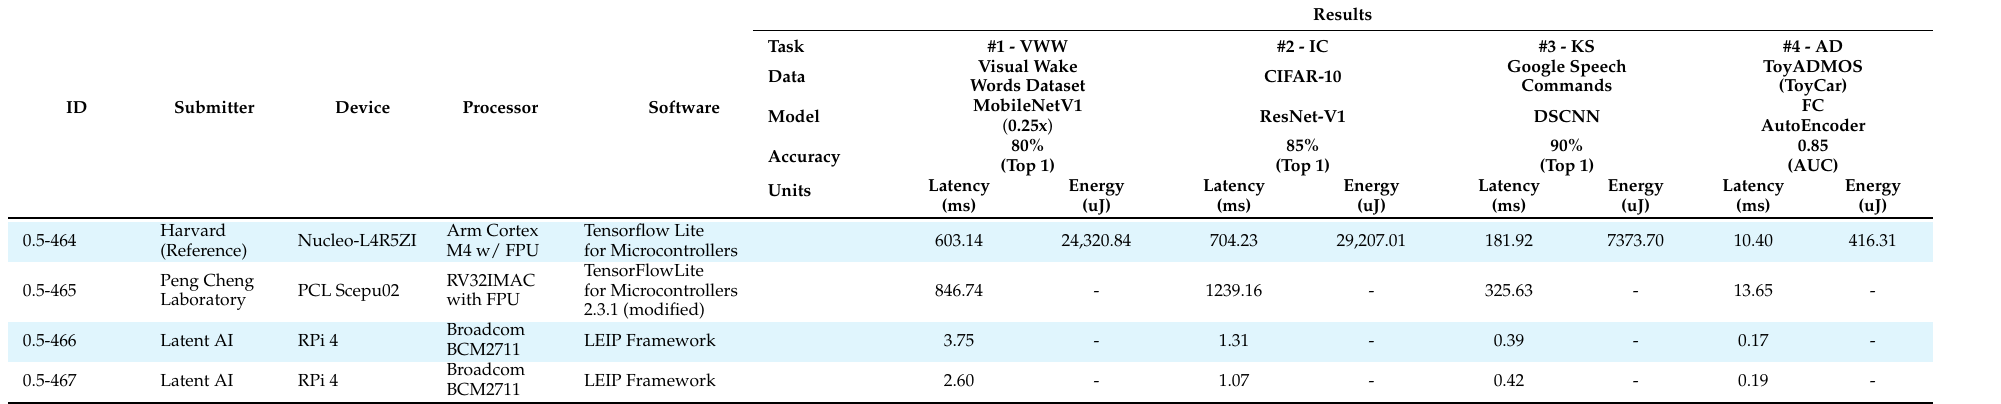
Table 3. MLPerf™ Tiny Inference v0.5 benchmark results. Data from